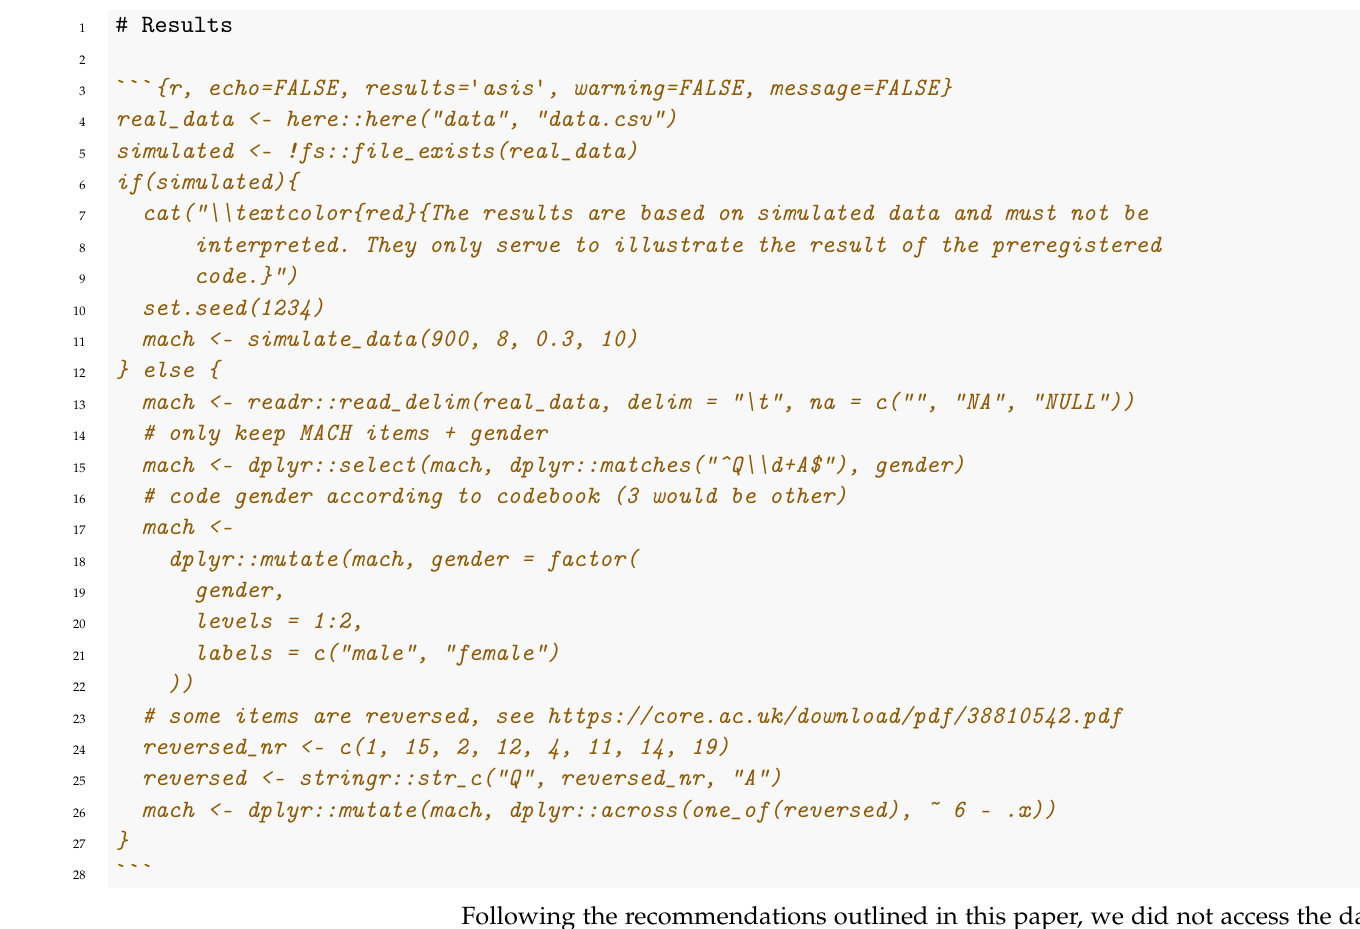
Figure 3. Results of simulation for the power analysis. The cross indicates the sample size that archives 80% assuming a Cohen’s d of